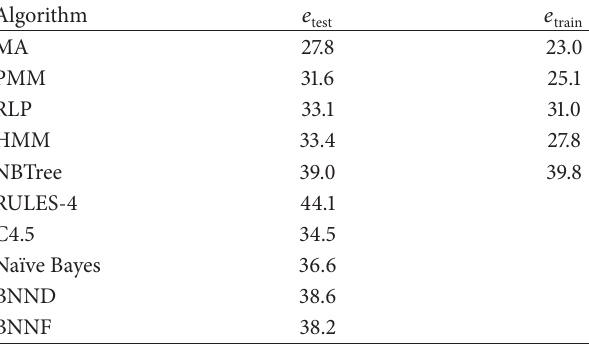
Table 6: Results in the liver dataset.